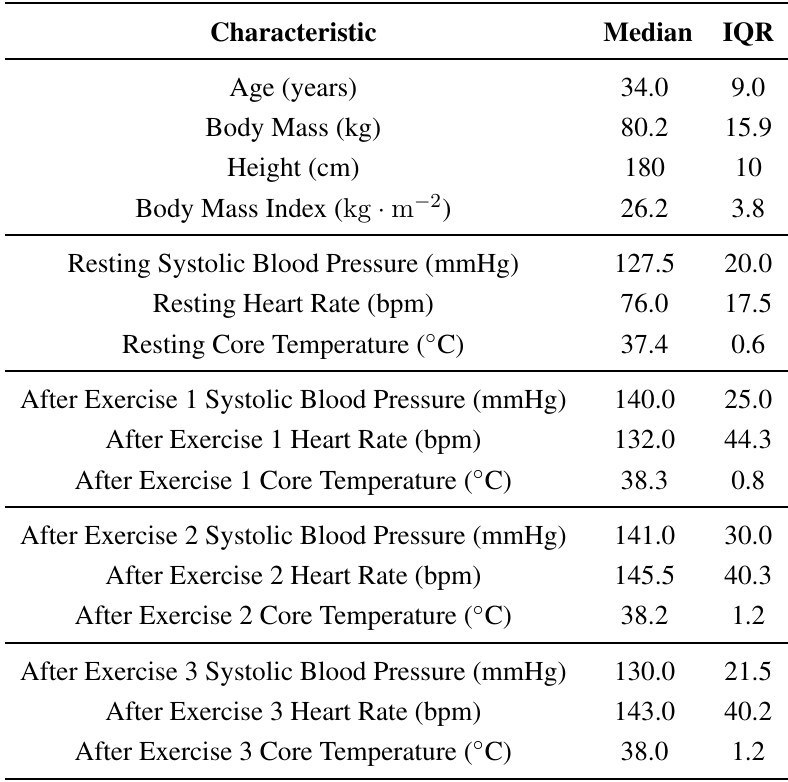
Table 1. Data for the participants in this study. Here, IQR stands for interquartile